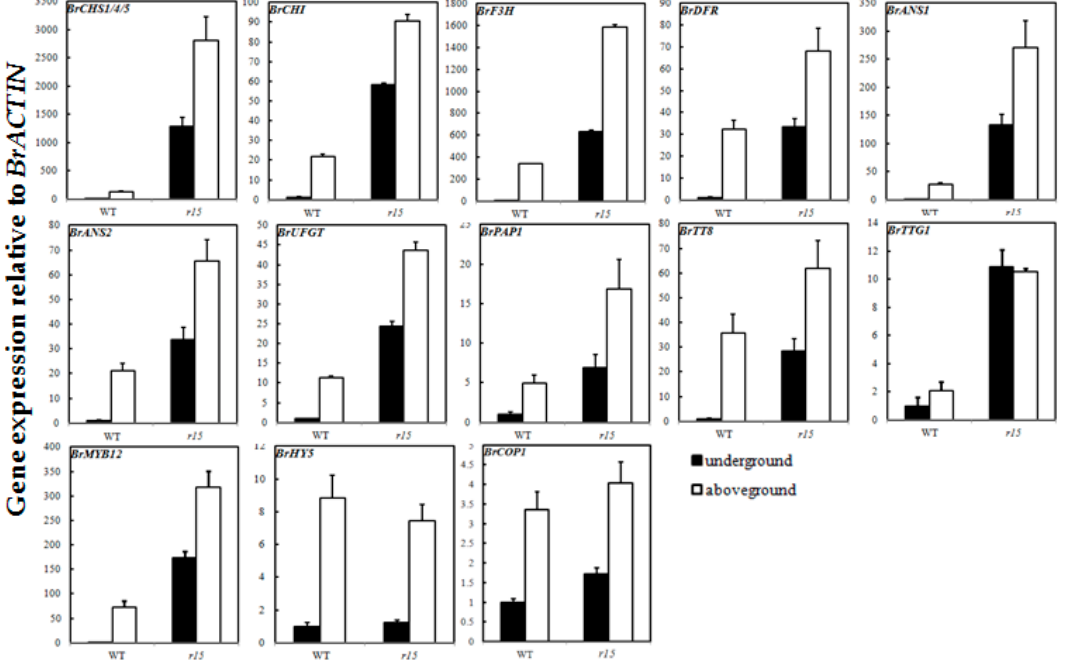
Figure 7. Expression analysis of anthocyanin biosynthesis genes and light responsive genes in underground and light-exposed parts of epidermis of swollen roots in r15 and WT. The expression value for each sample was normalized to that of the BrACTIN gene, and the transcript level in underground parts of epidermis of swollen roots was set as 1.0. The white columns, aboveground part of epidermis of swollen roots; black columns, underground part of epidermis of swollen roots. The mean values of three biological replicates are shown with error bars (SD).